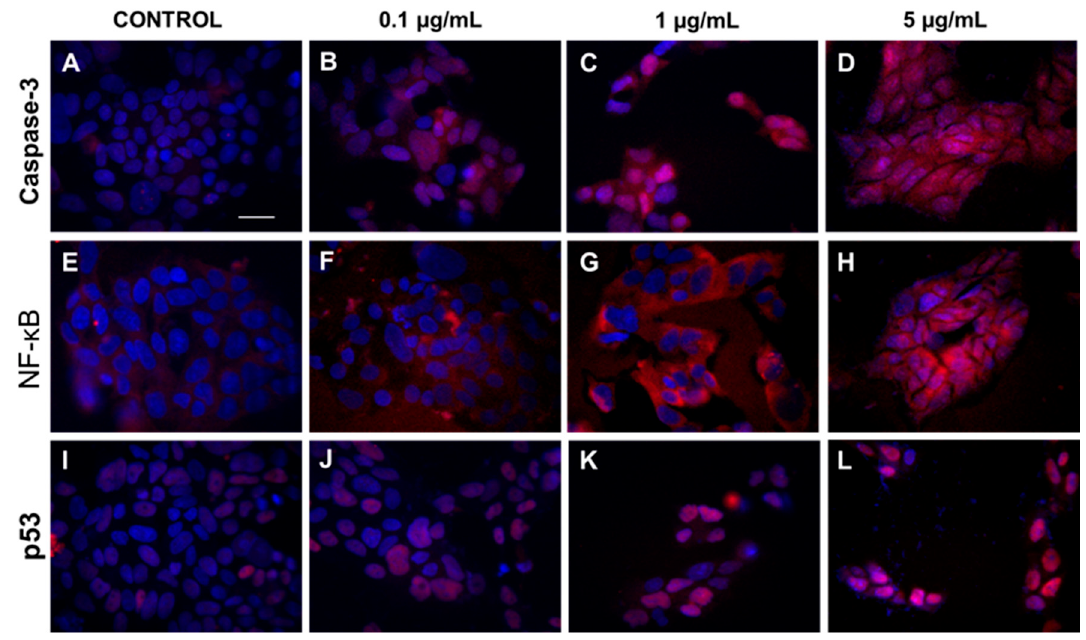
Figure 3. The cytoplasmatic and nucleus level of caspase-3, NF- κ B, and p53 in DLD-1 cell line after HA extract application. Panels ( A – D ) show expression of caspase 3 after treatment of DLD-1 by different concentrations of HA extract (0.1–5 μ g/mL). Increasing expression of NF- κ B and p53 protein after addition of HA extract at different concentration range 0.1–5 μ g/mL are showed at panels ( E – H ) and ( I – L ), respectively. Magnification 400×, Scale bar =20 μ m.